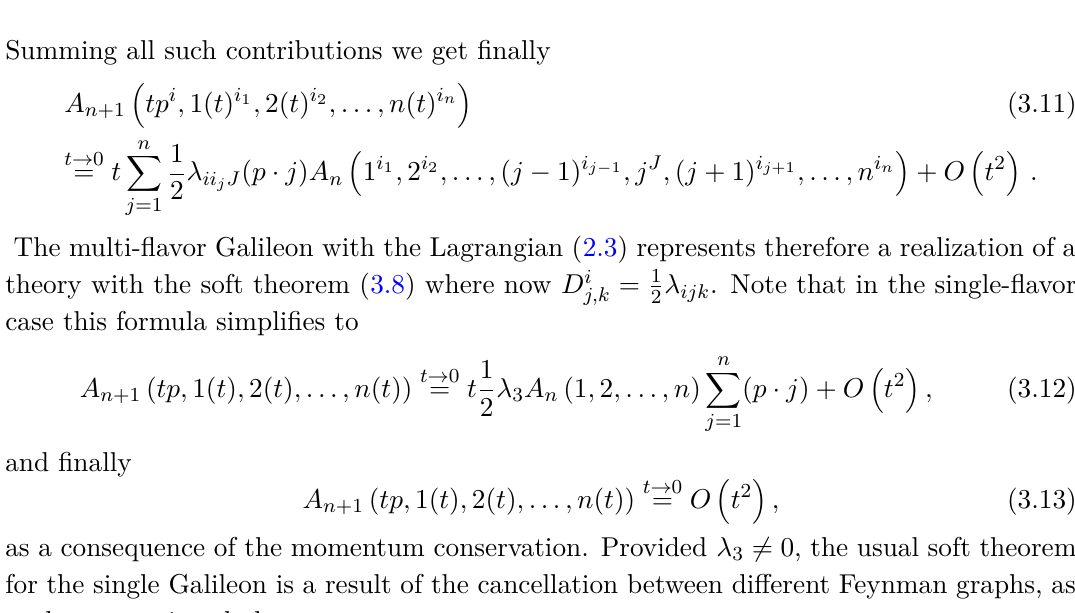
Figure 1 . The graphs with a nontrivial single-particle soft